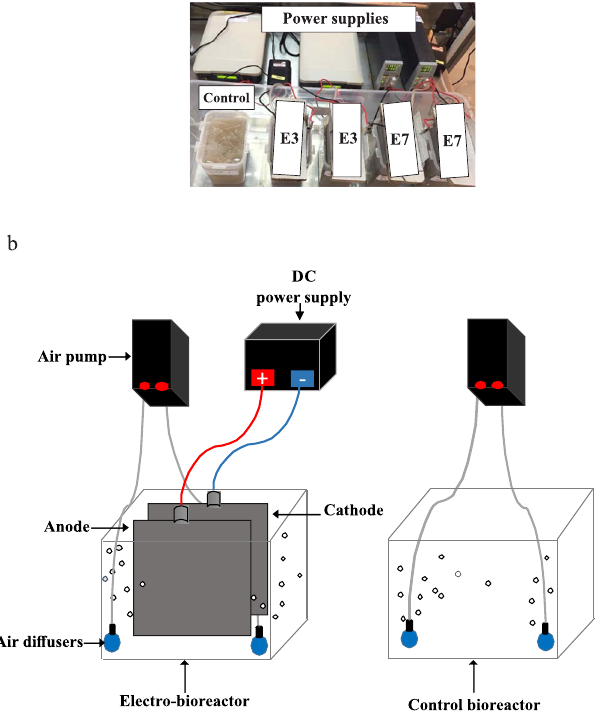
Figure 5. ( a ) Photograph and ( b ) schematic diagram of the experimental setup of serially passaged control bioreactor and electro-bioreactors operated at current densities 3 and 7 Am − 2